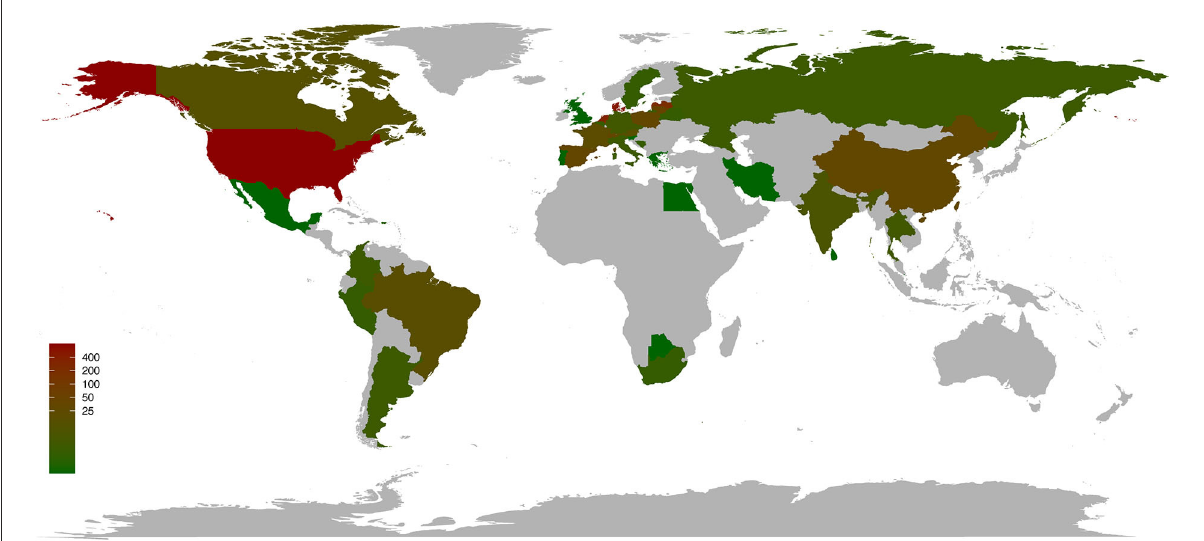
FIGURE1 Worldwide distribution of SARS-CoV-2 infections in animals by country. As of 21 August 2022, 39 countries have reported confirmed cases of SARS-CoV-2 in animals. Data were obtained from COVID19 DASHBOARD ANIMALS GLOBAL (https://public.tableau.com/app/profile/raj. rajnarayanan/viz/COVID19DASHBOARDANIMALSGLOBAL/AnimalCov-Global).